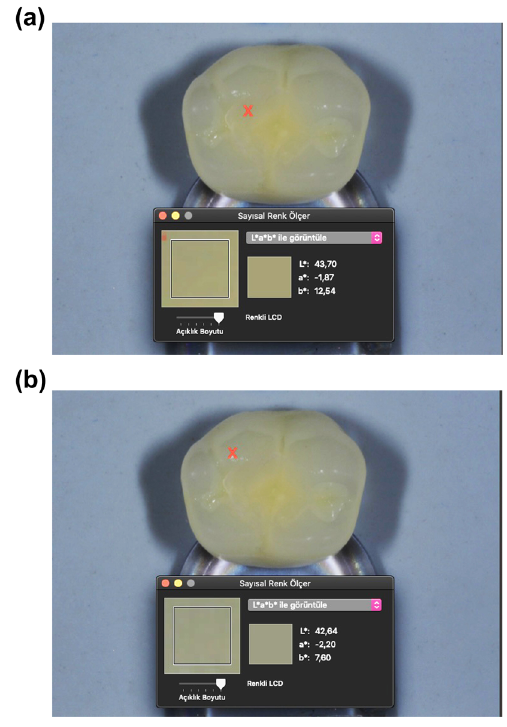
Figure 4: ( a and b ) Measurement of the quantitative L *, a *, and b * coordinates of the restoration and the denture in Color Mine software.